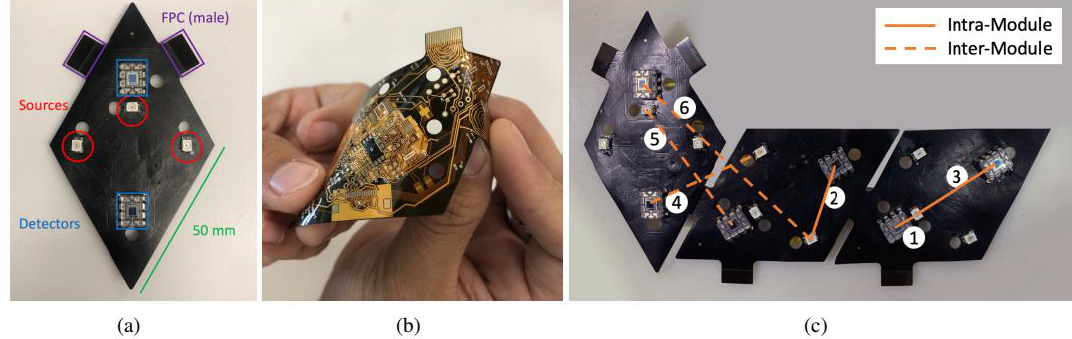
Figure 11. ( a ) The AOBI module ( b ) Top view of the flexible circuit board ( c ) A three-module configuration emphasizing. Reproduced from reference [62].